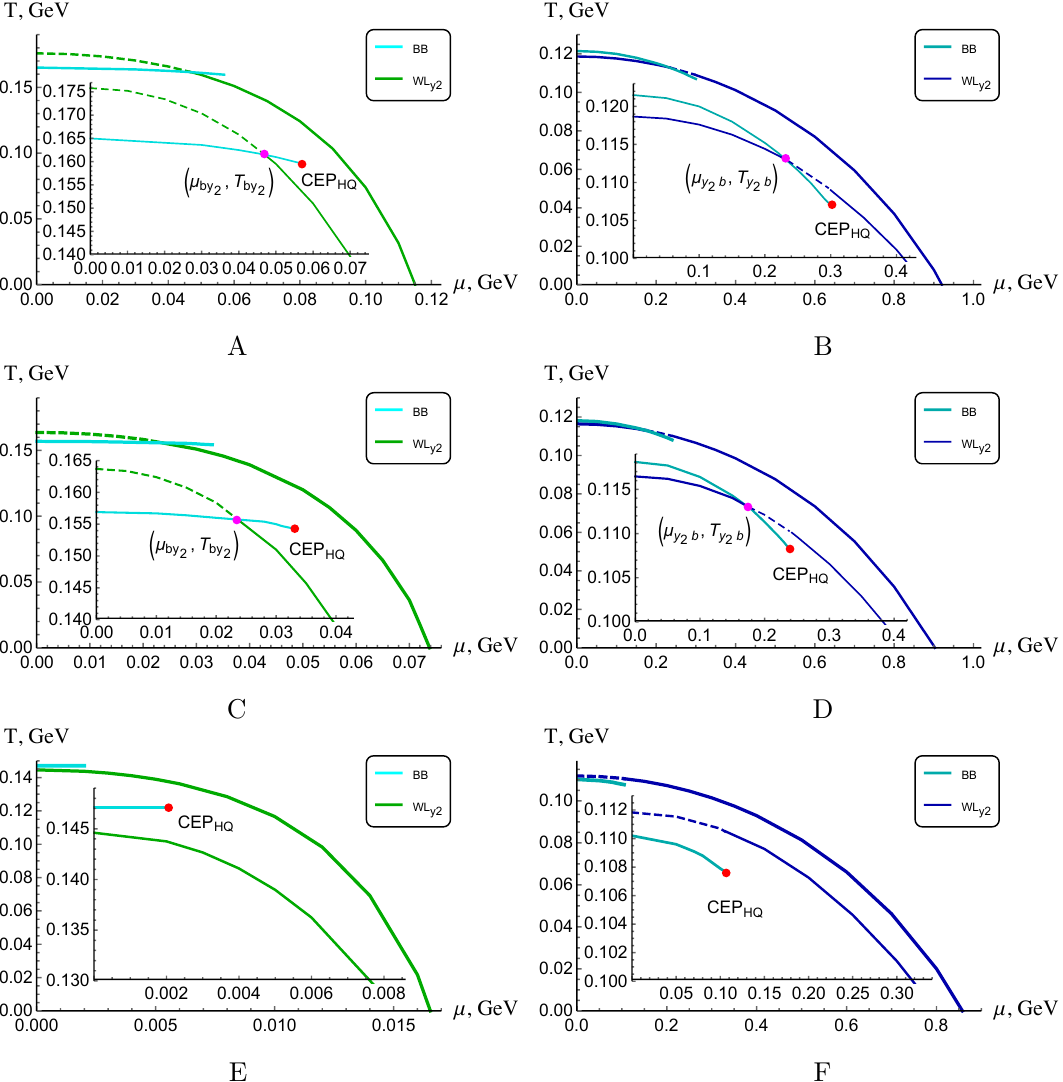
Figure 16 . Phase diagram for y 2 -orientation for c B = 0 , ν = 1 (A) and ν = 4 . 5 (B), c B = − 0 . 005 , ν = 1 (C) and ν = 4 . 5 (D), c B = − 0 . 0096 , ν = 1 (E) and c B = − 0 . 015 , ν = 4 . 5 (F); c = 0 . 227